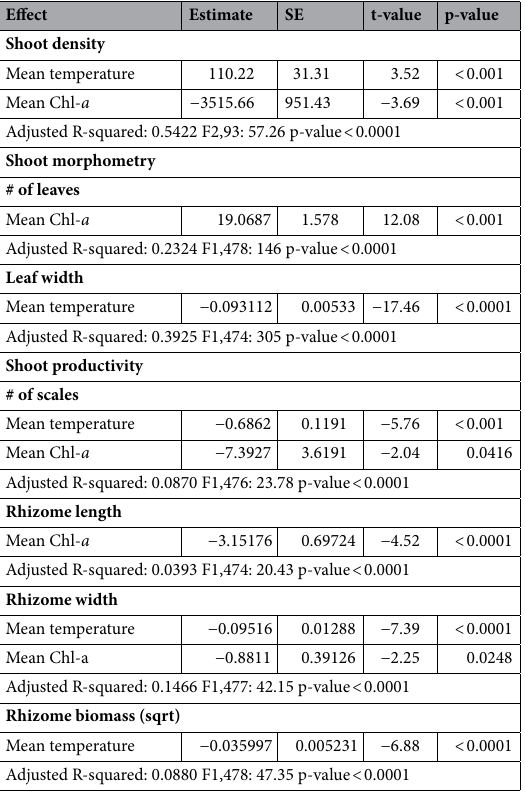
Table 2. Multiple regressions outputs of Posidonia oceanica response variables against the predictors retained in the model by the backward